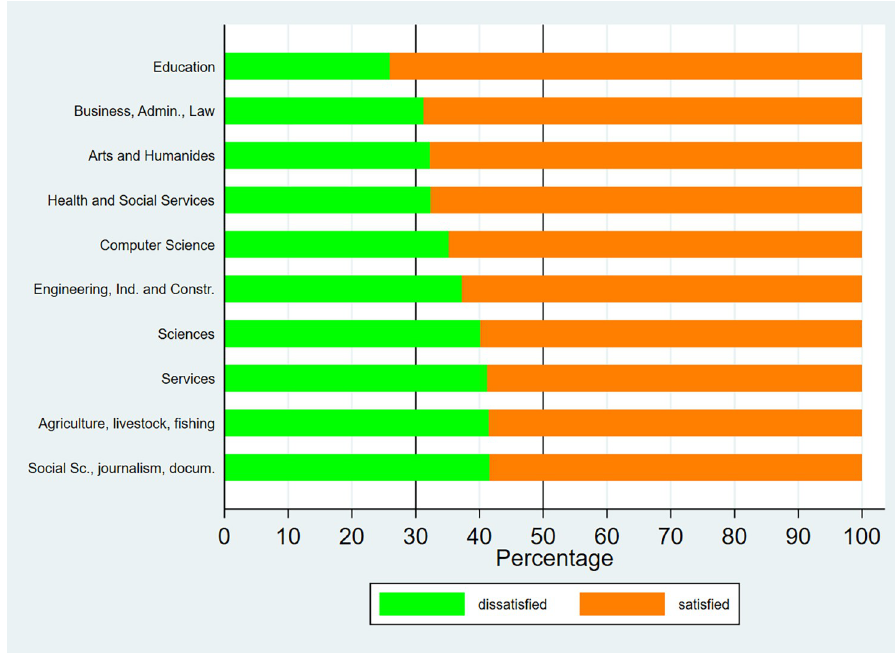
Fig 3. Satisfaction with university education by fields of study (Master—2019). Source: University Graduate Job Placement Survey 2019 (INE). Own